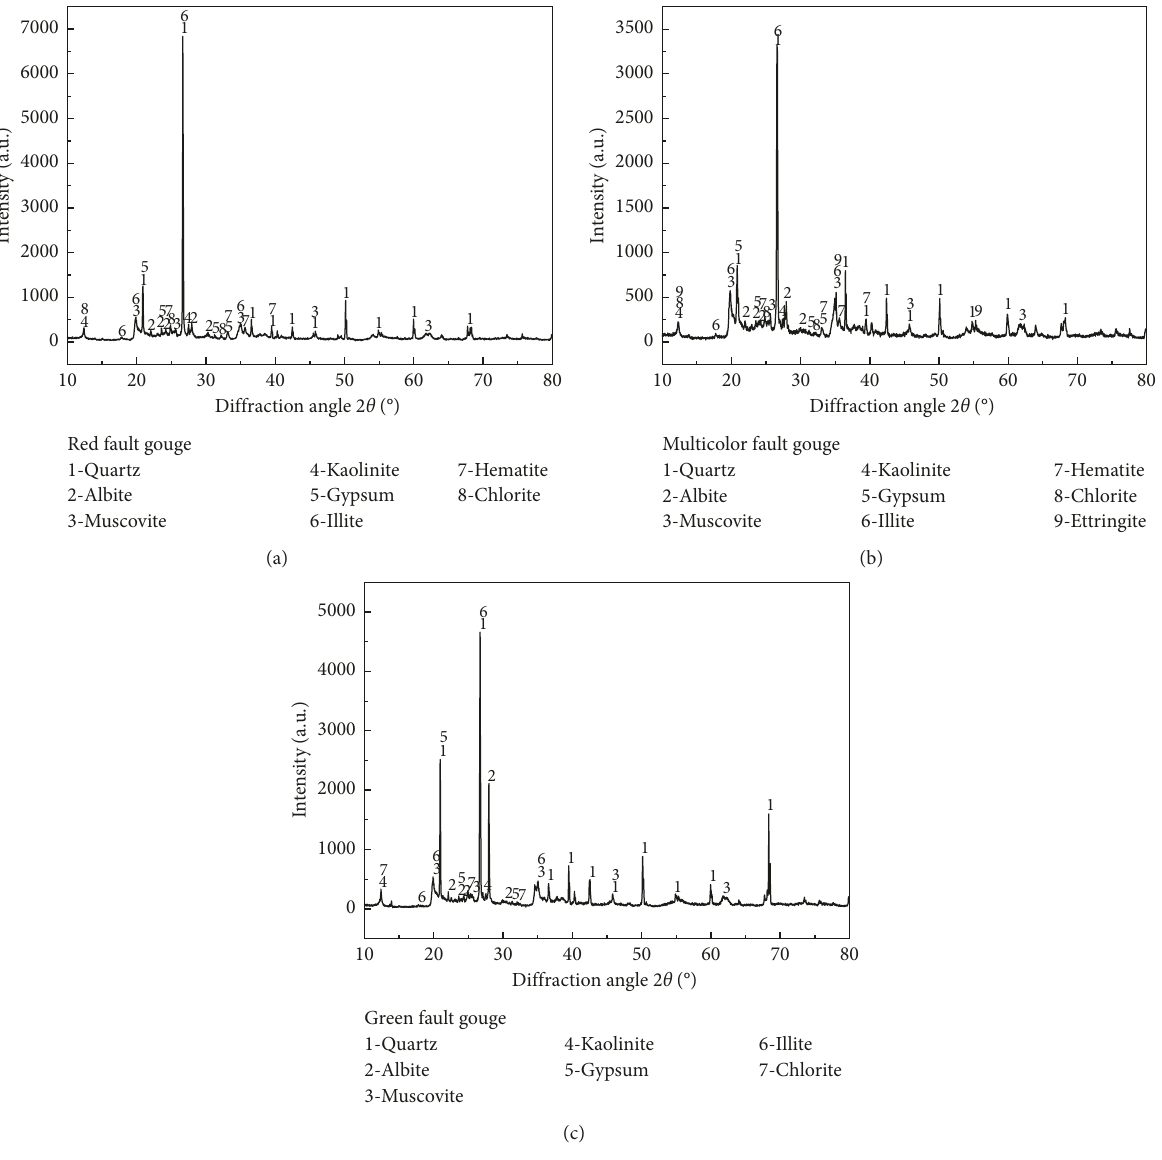
Figure 8: X-ray diffraction patterns. Table 2: Semiquantitative analysis of mineral component in fault gouges